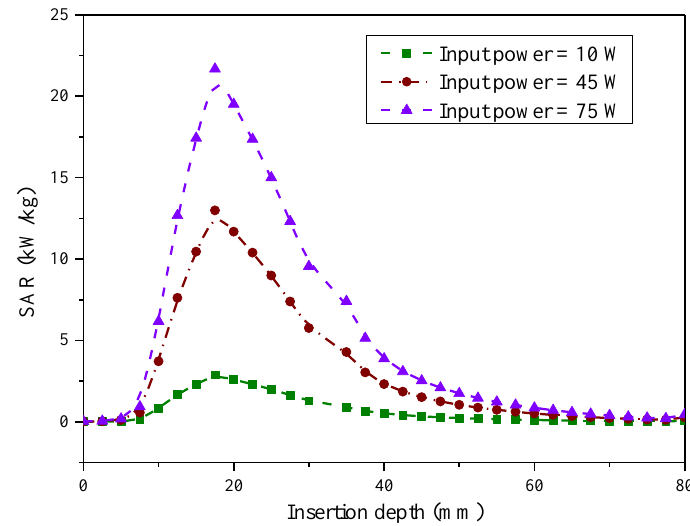
Figure 8. Axial profile of specific absorption rate (SAR) at t = 300 s and r = 2.5 mm for various input powers.